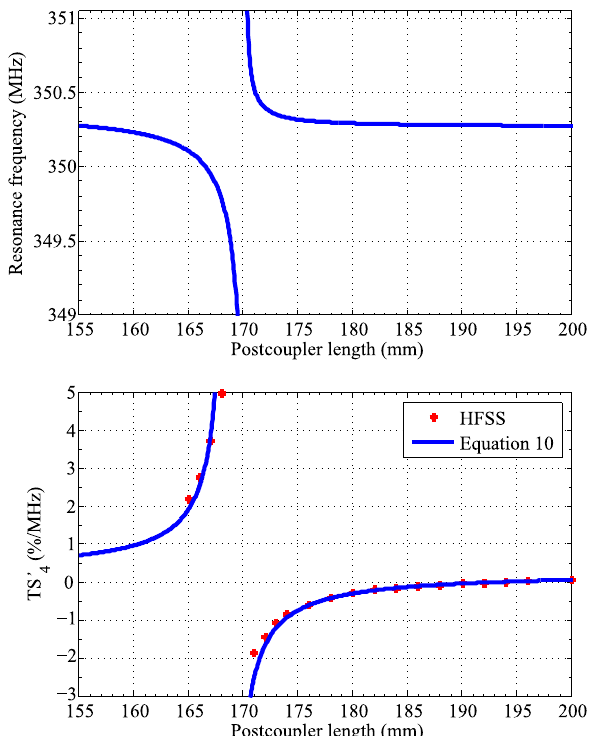
FIG. 3. Top: Variation of the resonance frequency of the TM 010 mode as a function of the length of post-coupler 4 l 00 4 . Bottom: Simulation of TS 0 4 (dotted) fitted by equation